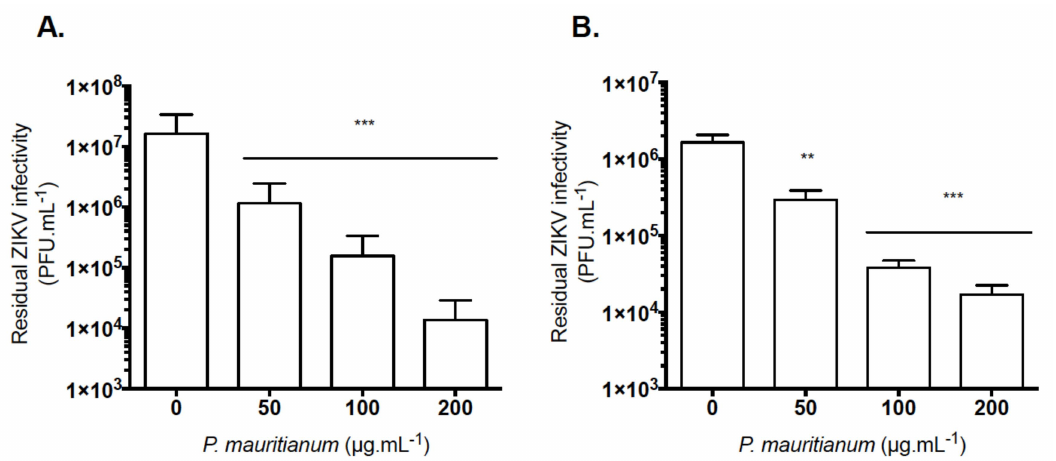
Figure 5. The P. mauritianum extract reduces the viral progeny production of the African and Asian ZIKV lineages. ( A ) ZIKV-MR766 or ( B ) ZIKV-PF13 were incubated with di ff erent concentrations of the P. mauritianum extract for 1 h at 37 ◦ C. The Vero cells were infected at a MOI of 1 for 24 h. The release of infectious viral particles was measured by plaque forming assays. The results shown are the means ± SD of three independent experiments. Statistical analyses were performed using a one-way ANOVA and Dunnett’s test for multiple comparisons (** p < 0.01; *** p <